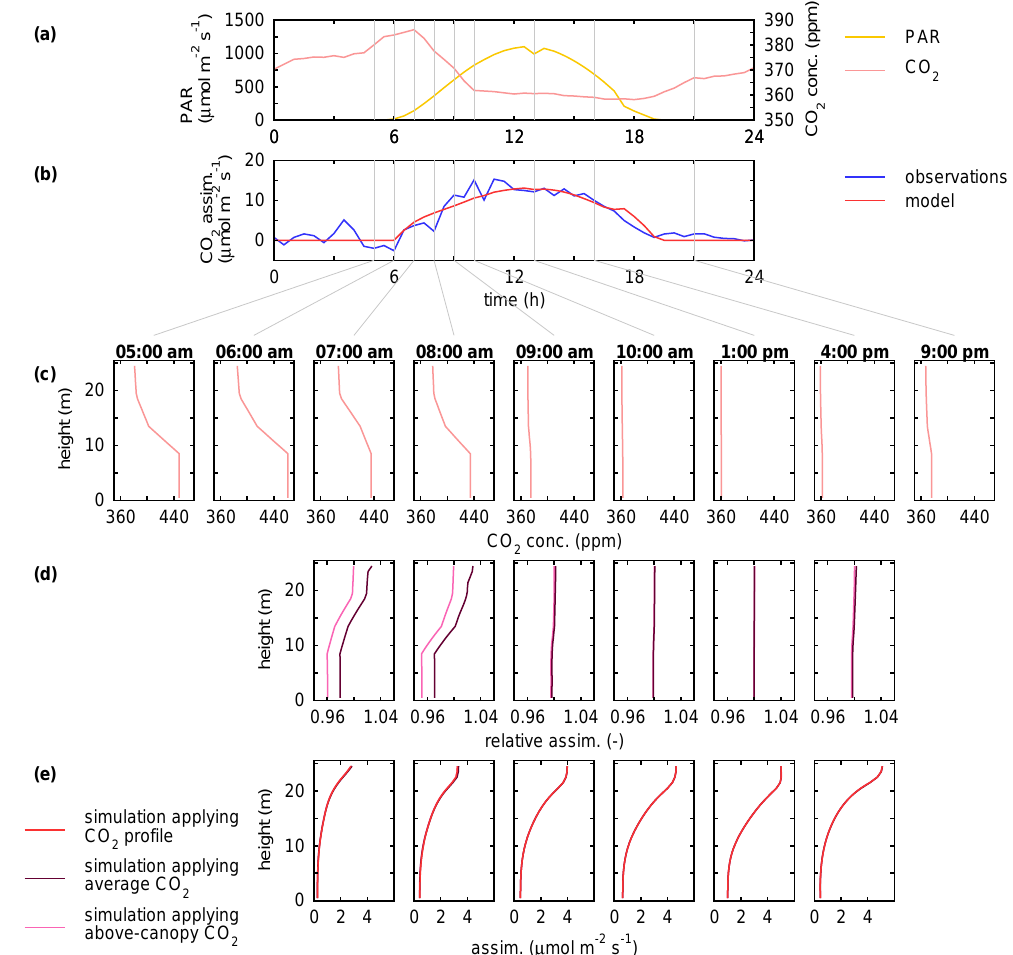
Figure 9. Changes in the within-canopy CO 2 profile, and its impact on CO 2 assimilation, illustrated for 12 September 1999: (a) observed changes in PAR and above-canopy (28m) CO 2 concentration; (b) simulated and observation-derived CO 2 assimilation; (c) within-canopy CO 2 profile for nine selected times; (d) relative deviations from simulated CO 2 assimilation when applying average (simulation HOM_CO2) or above-canopy (simulation HOM_CO2_AC) CO 2 concentrations instead of the distribution displayed in (c) ; (e) simulated CO 2 assimilation for simulations applying the CO 2 distribution as well as canopy-average or above-canopy CO 2 concentration. For (d) and (e) , only daytime panels were